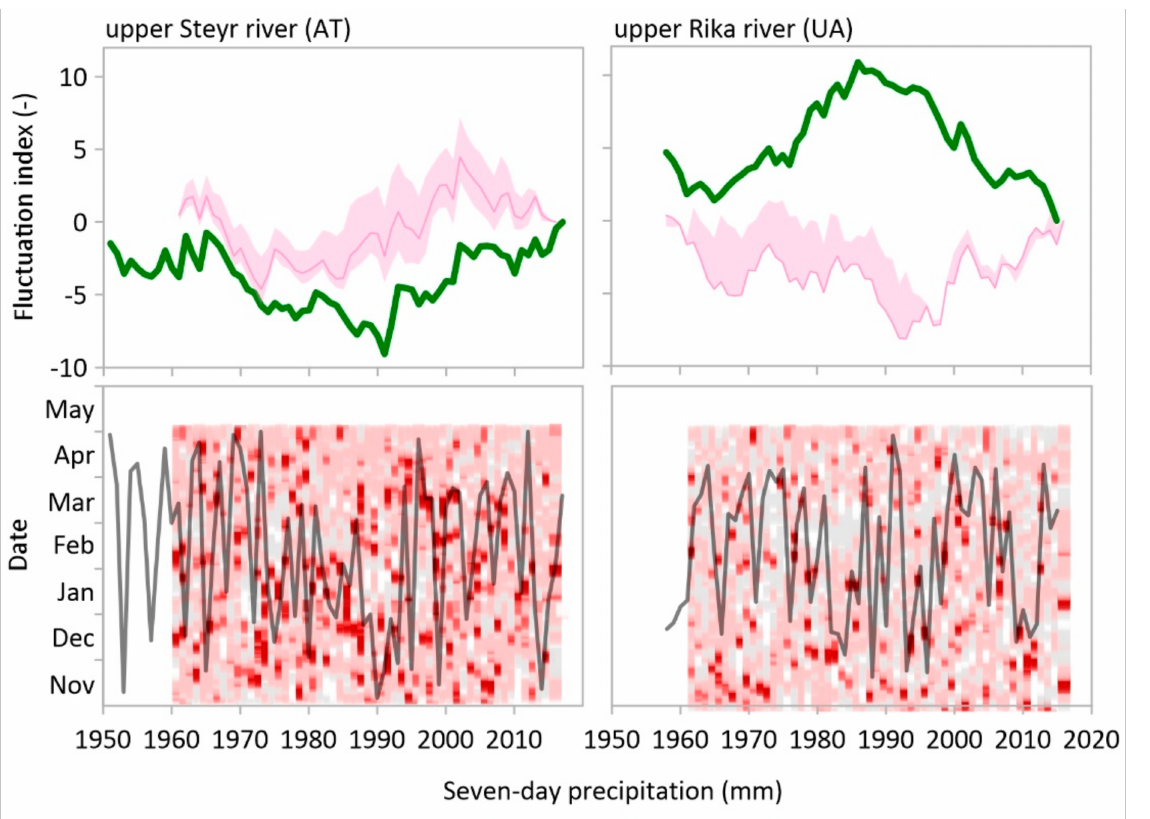
Figure 6. Fluctuations ( top panels) and seasonality ( bottom panels) of the winter maximum seven − day precipitation in the upper Steyr and the upper Rika catchments. Variability in max- imum precipitation (pink band in left top panel) is plotted for all sub-catchments in the upper Steyr catchment. For Mizhhiria station in the upper Rika River ( top right panel), the pink band indicates the variability between precipitation observations at three (Mizhhiria, Nyzhnii Studenyi, Verkhnii Bystryi) climate stations (Table 4). The green line indicates the fluctuation index of the winter floods ( top panels). Bold lines ( bottom panels) represent the season of the maximum precipitation in each